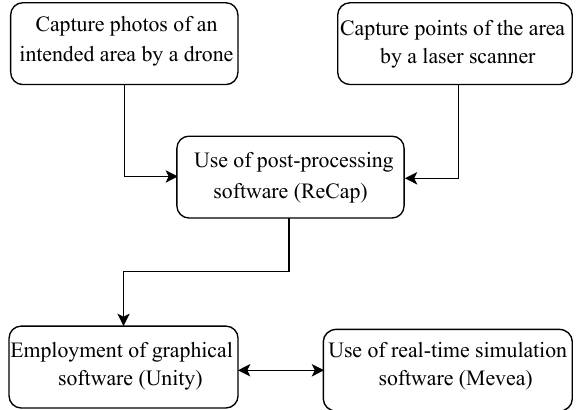
Figure 8. Process steps to generate an environment for real-time simulation software using a photogrammetry approach and Unity